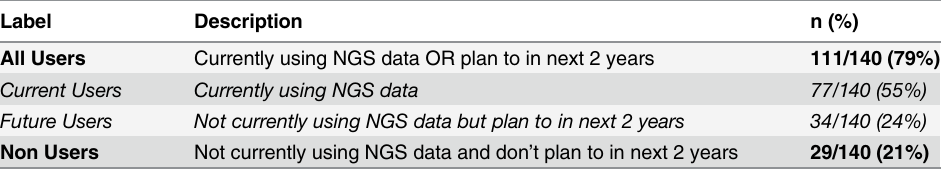
Table 1. Number of respondents by use of